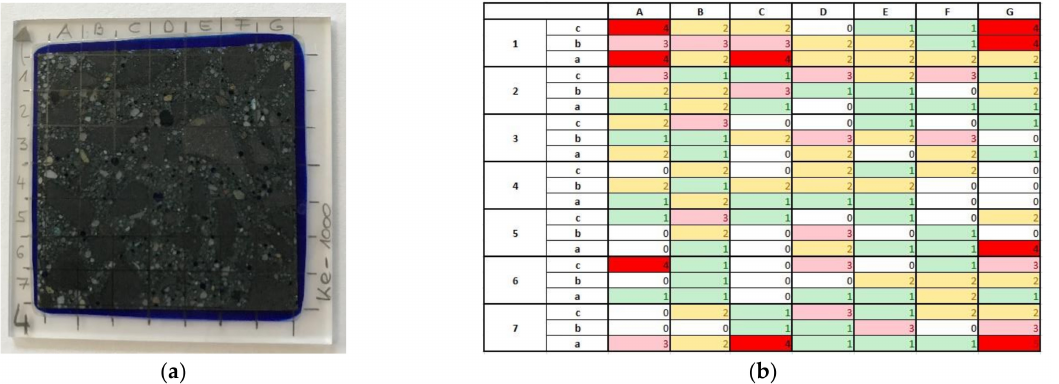
Figure 14. ( a ) Example of a thick section with examination field of 35 × 35 mm 2 and a raster of 7 × 7 cells and ( b ) example of tabular examination of crack amount: white = no cracks; green = one crack; yellow = 2 cracks; pink = 3 cracks; red = more than 3 cracks.